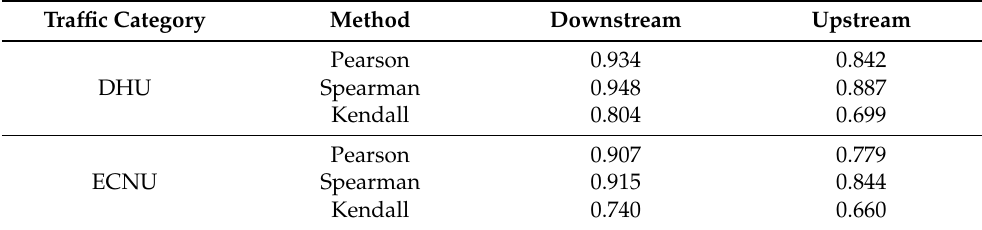
Table 2. The correlation coefficient between IPv4 and IPv6